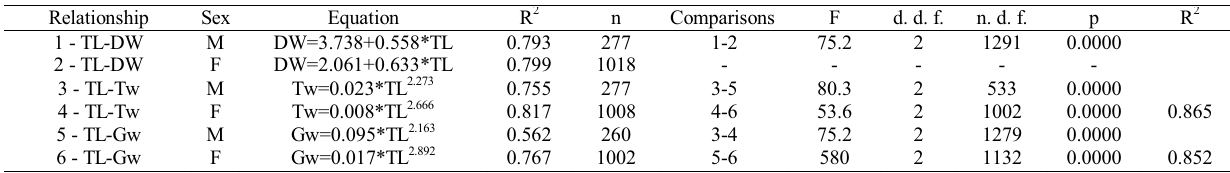
Table 3. Relationships analyzed for Rioraja agassizi : TL=total length (cm); DW=total width (cm); Tw=total weight (g); and Gw=gutted weight (g) for males (M) and females (F), along with the respective regression equation and correlation coefficient (R 2 ), sample number (n); pair of relationships compared (comparisons) by F-test (F), along with degrees of freedom of the numerator (n. d. f.) and denominator (d. d. f), probability (p).